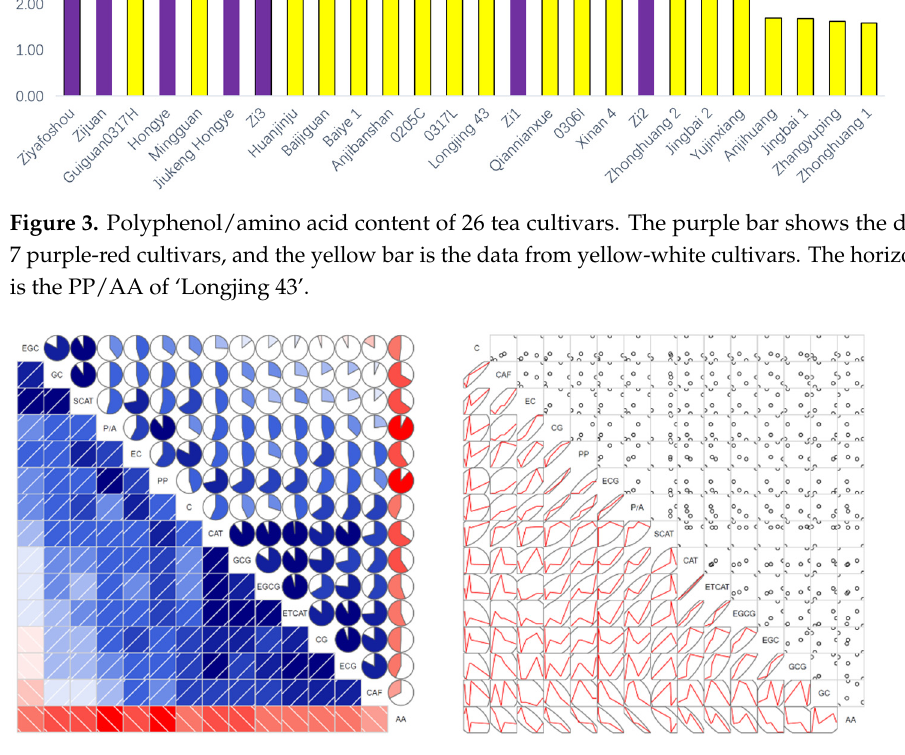
Figure 3. Polyphenol/amino acid content of 26 tea cultivars. The purple bar shows the data from 7 purple-red cultivars, and the yellow bar is the data from yellow-white cultivars. The horizontal line is the PP/AA of ‘Longjing 43’.